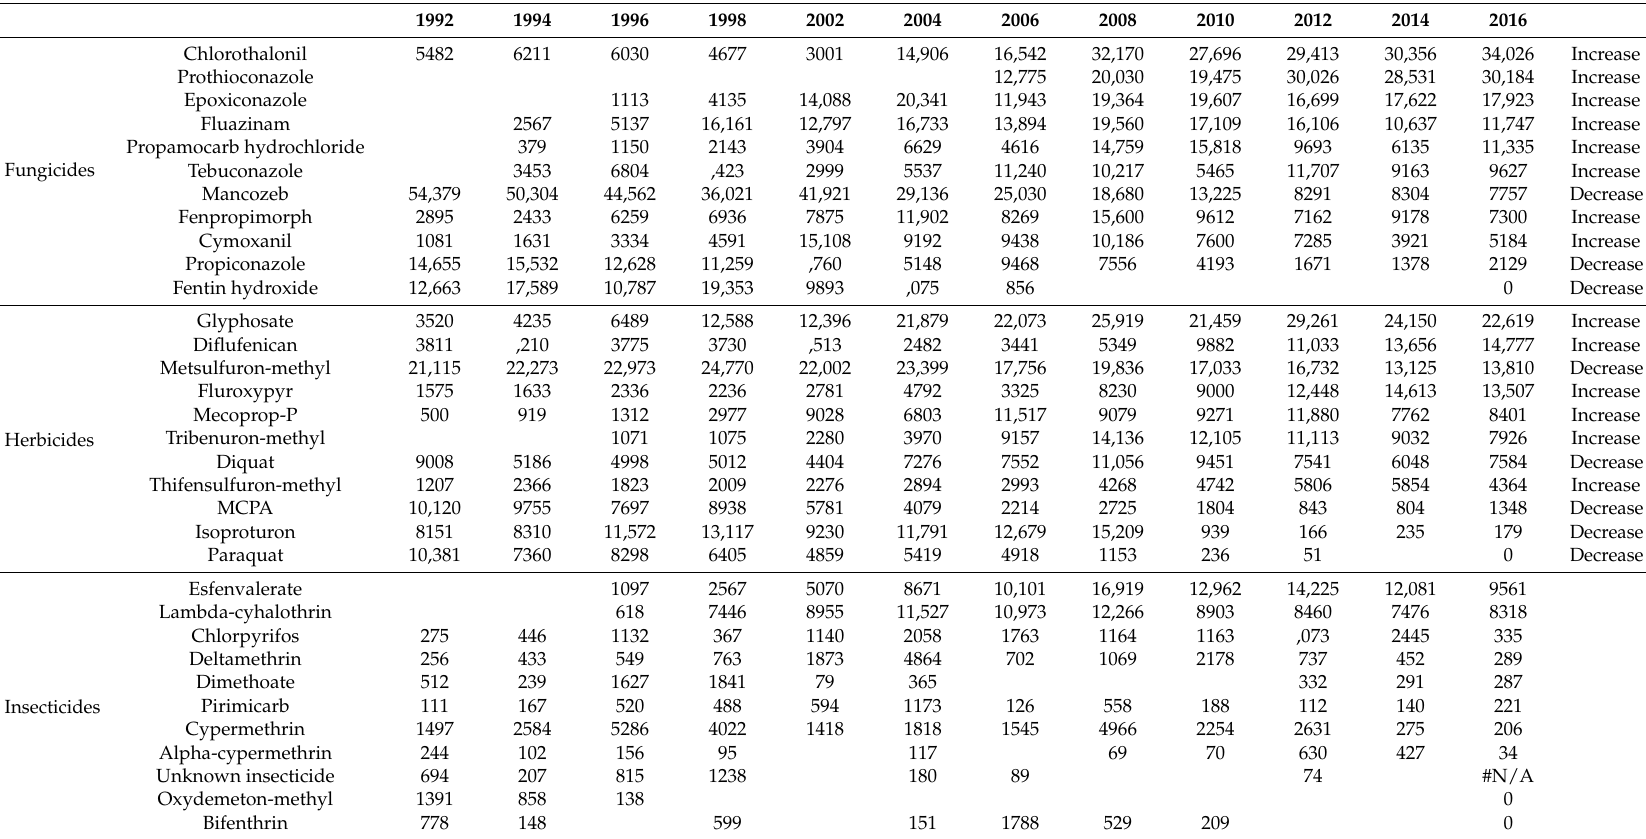
Table 6. The most commonly used active substances from the major pesticide groups 1992-2016, prioritised by treated area